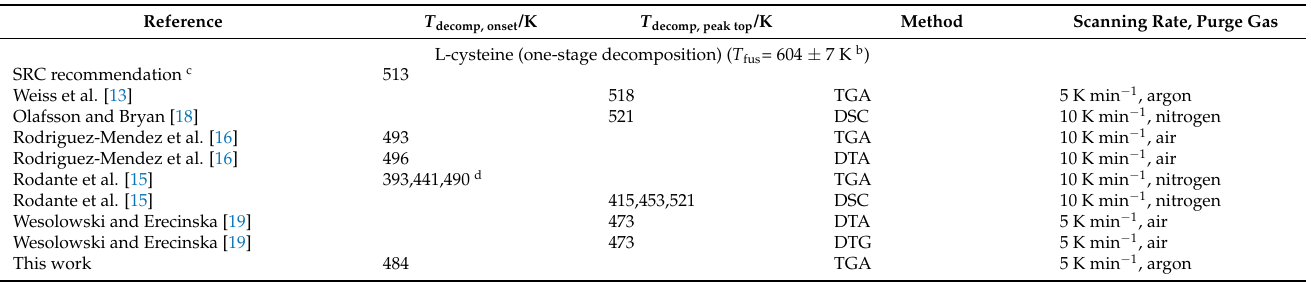
Table 1. Temperatures of Fusion and Decomposition of L-Cysteine, L-Serine, L-Threonine, L-Lysine, and L-Methionine a